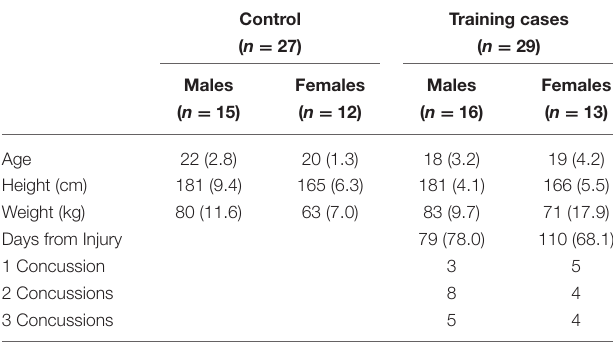
TABLE 4 | Training set used to generate all predictive